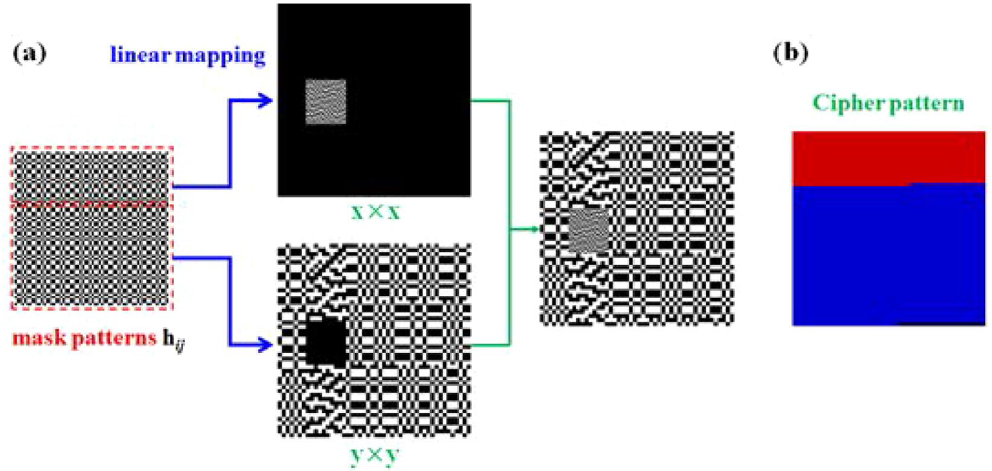
Figure 1. ( a ) Schematic diagram of generating a composite light pattern (64 × 64) in Experiment A and ( b ) cipher pattern corresponding to the linear mapping